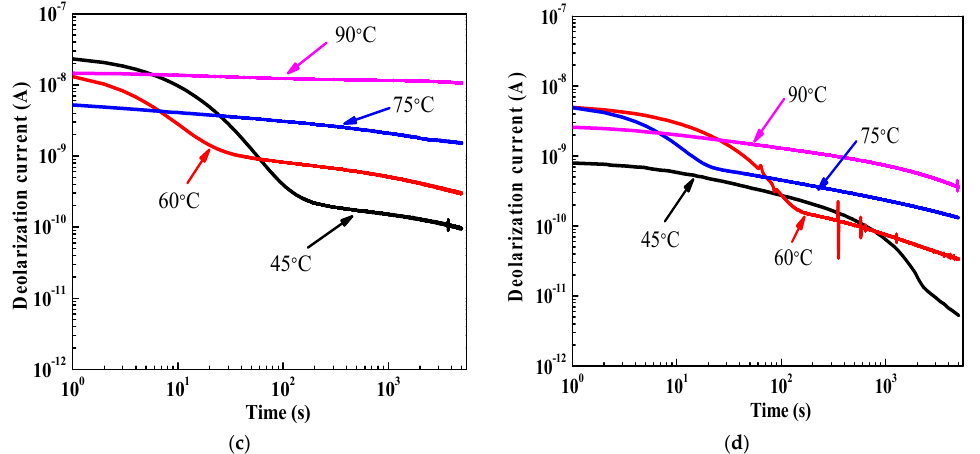
Figure 6. Measurement results of depolarization current of oil-impregnated pressboard specimens with various insulation statuses. ( a ) Ageing 0 day (DP = 1285), moisture content 4.02%; ( b ) Ageing 8 days (DP = 994), moisture content 2.82%; ( c ) Ageing 21 days (DP = 841), moisture content 3.71%; and, ( d ) Ageing 42 days (DP = 415), moisture content 1.17%.